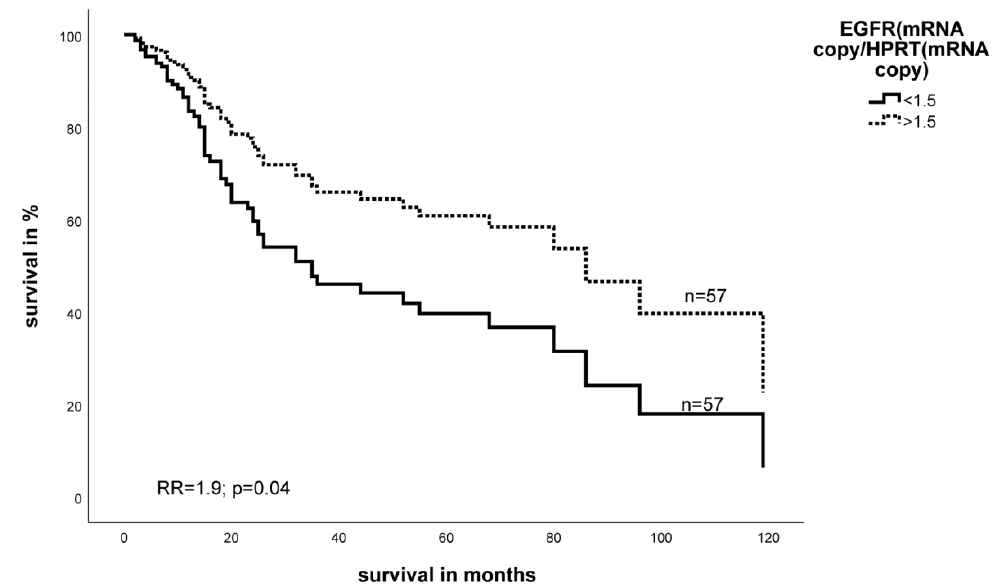
Figure 2. Multivariate Cox’s hazard regression model for EGFR mRNA expression and tumor-specific survival in STS patients.Expression of EGFR for 114 STS patients was associated with survival. The model was adjusted for tumor stage, tumor localization, tumor entity, and the type of tumor resection. The high and low cut-off values for EGFR were >1.5 and ≤1.5 copies of EGFR mRNA relative to the number of copies of HPRT mRNA, respectively (RR = 1.9, p = 0.04).